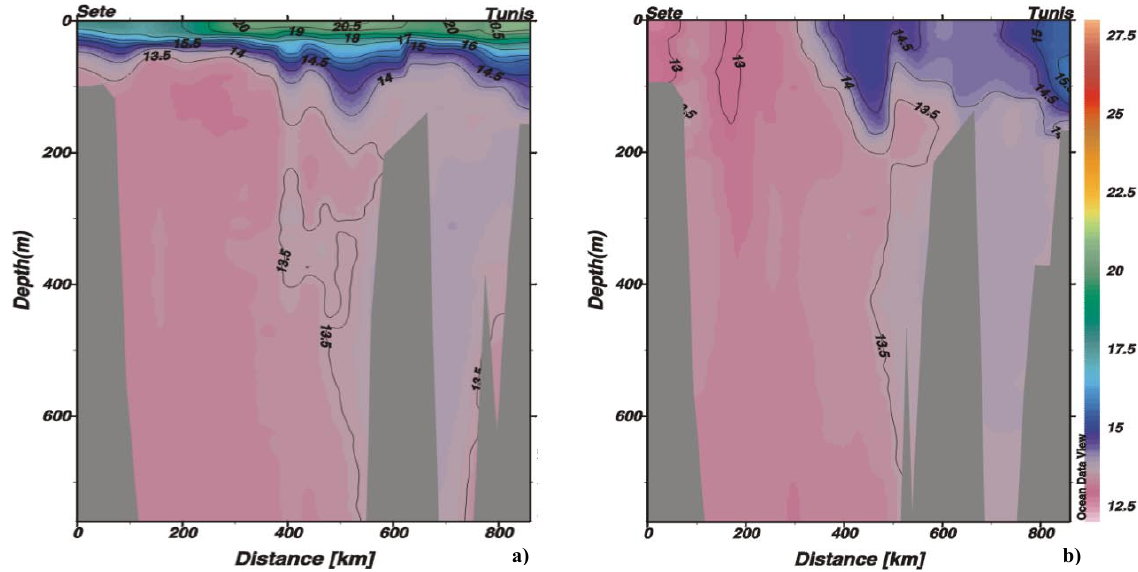
Fig. 8. Temperature vertical sections from Sete to Tunis (track 3) in May 2000 (a) and in January 2000 (b)